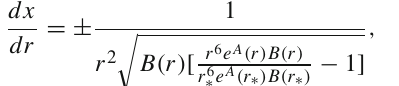
Fig. 2 The phase structure of scalar operator with LNE in AdS soliton background. The critical chemical potential of the insula- tor/superconductor phase transition is μ c (cid:8) = 2 .